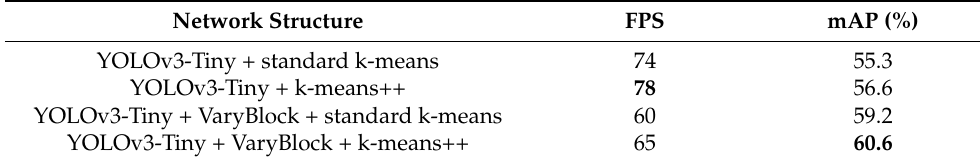
Table 7. The test results with k-means++ and standard